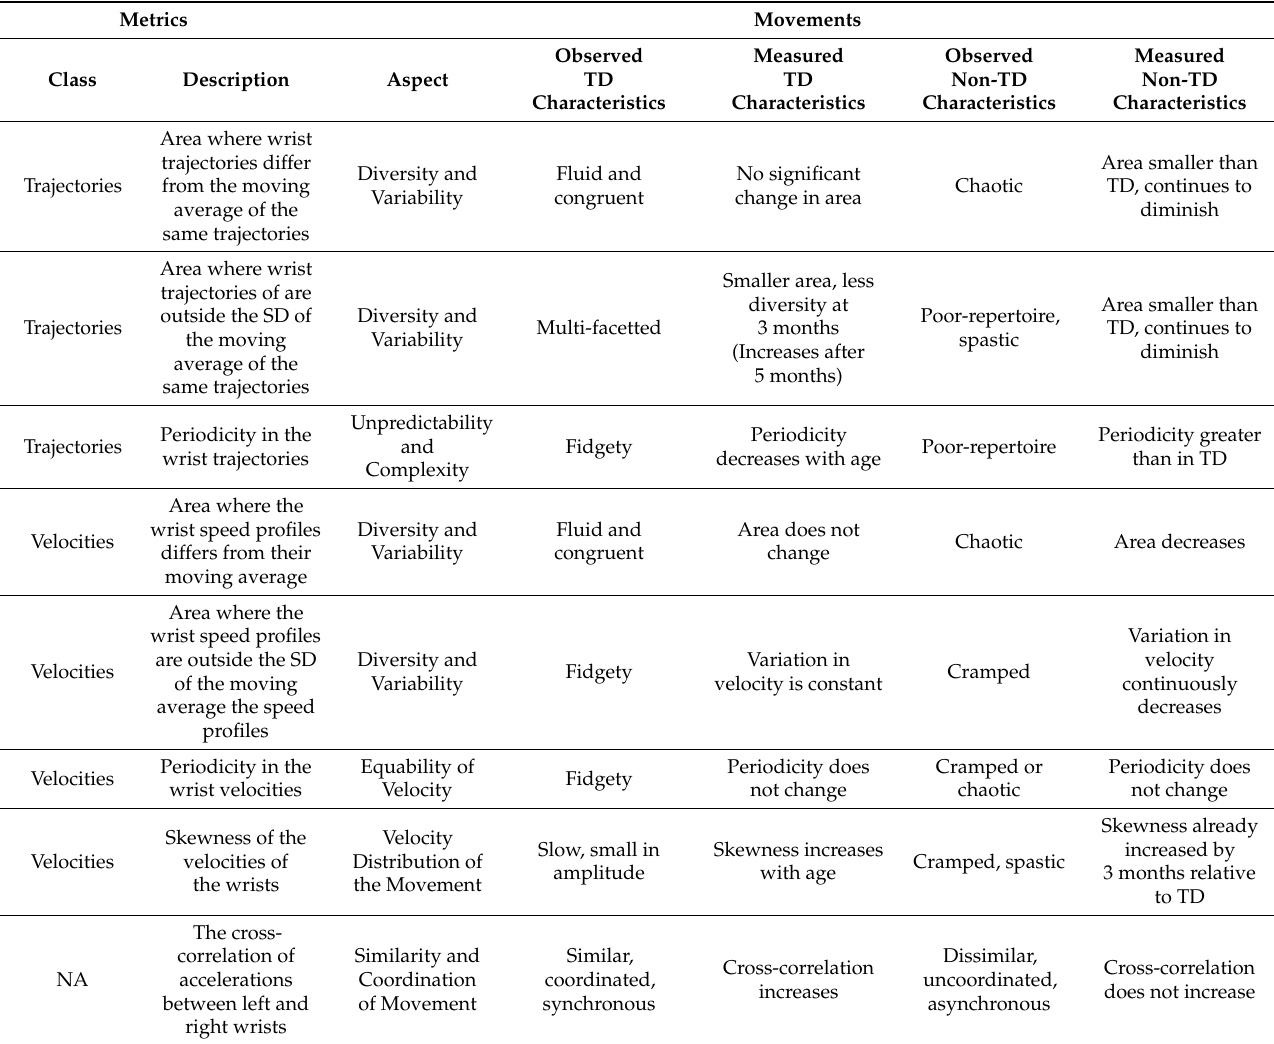
Table 2. Mapping of observed patterns of general movements at 3–5 months of age to kinematic parameters. Adapted from ref.